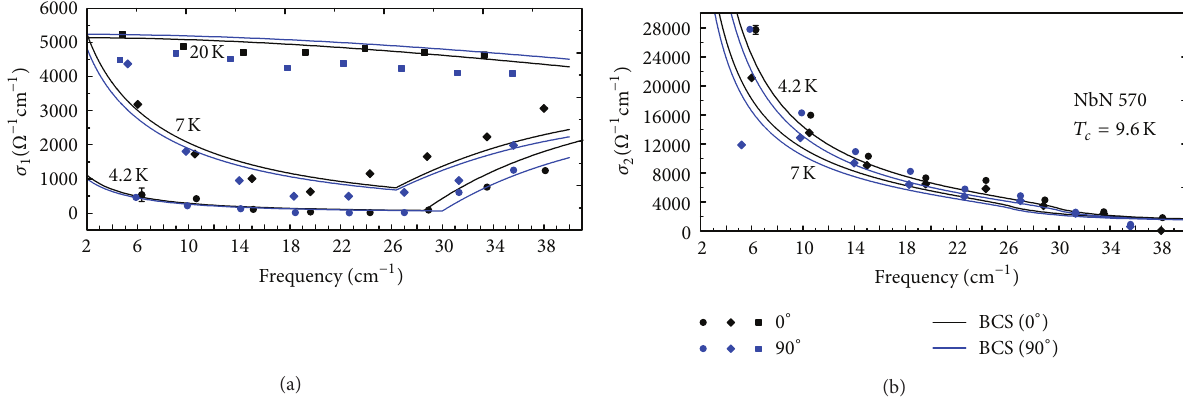
Figure 16: (a) Real part and (b) imaginary part of the complex conductivity versus frequency for 4.2 K (dots) and 7 K (diamonds) well below = 9.6 K and 20K (squares) in the normal state for both main axes of a NbN film. Solid black and blue lines are predictions calculated 𝑇 𝑐 directly from raw data fits for both axes individually. The kink in 𝜎 1 signaling the energy gap is resolved clearly. The error bar shown is representative for all data (after